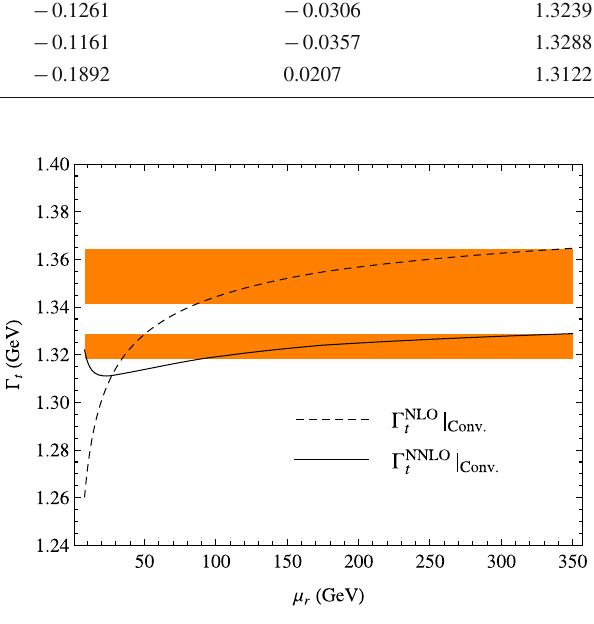
Fig. 1 Thetop-quarkdecaywidths (cid:5) t versustherenormalizationscale μ r using conventional (Conv.) scale setting, where the dashed and solid lines stand for the conventional predictions (cid:5) NLO t | Conv . at NLO and (cid:5) NNLO | Conv . at NNLO, respectively. Two orange bands stand for the t estimation of the unknown higher-order QCD terms by using the con- ventional method of μ r ∈ [ m t / 2 , 2 m t ]